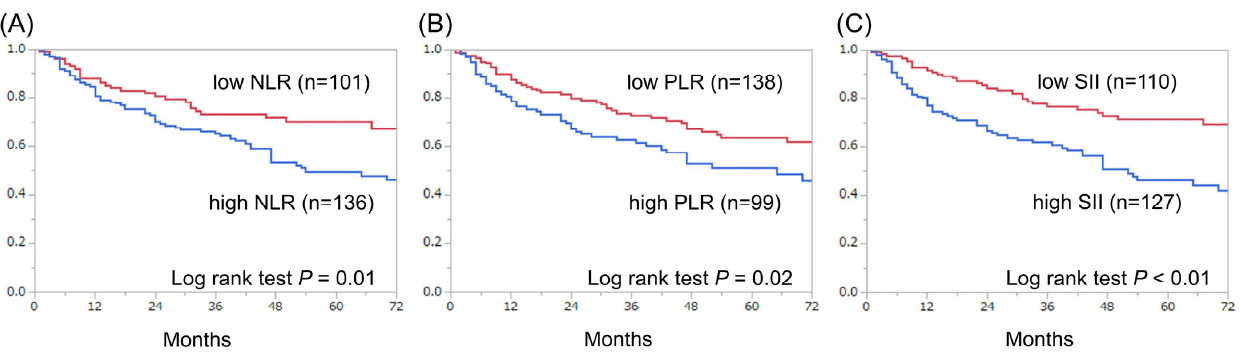
Figure 3 . Kaplan–Meier curves for OS according to preoperative NLR ( A ), PLR ( B ) and SII ( C ) .